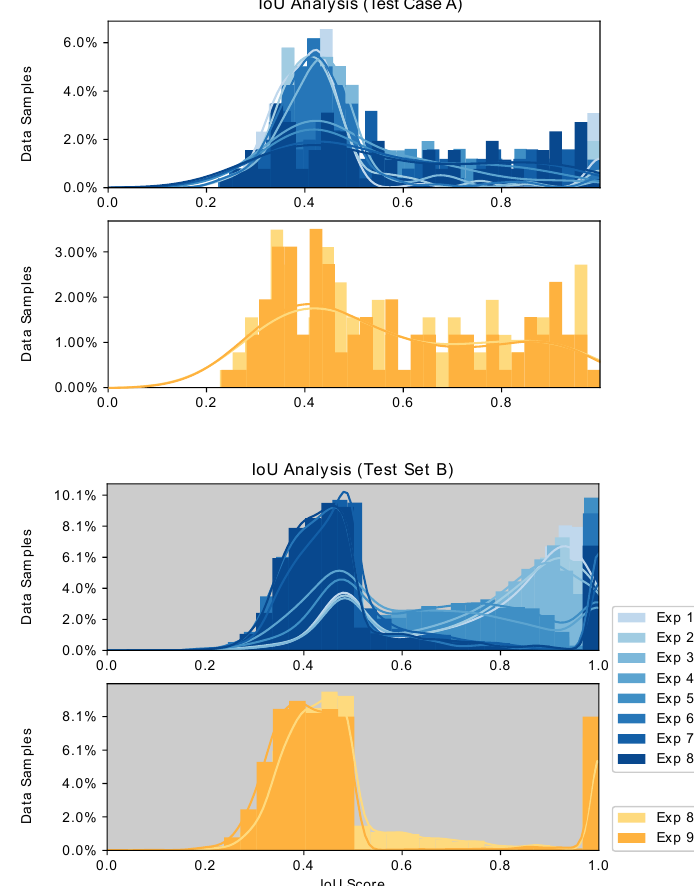
Figure 9. Histograms and distribution curves of the IoU scores of Exp. 1–8 and Exp. 8,9 evaluated on Test Set A and Test Set B .